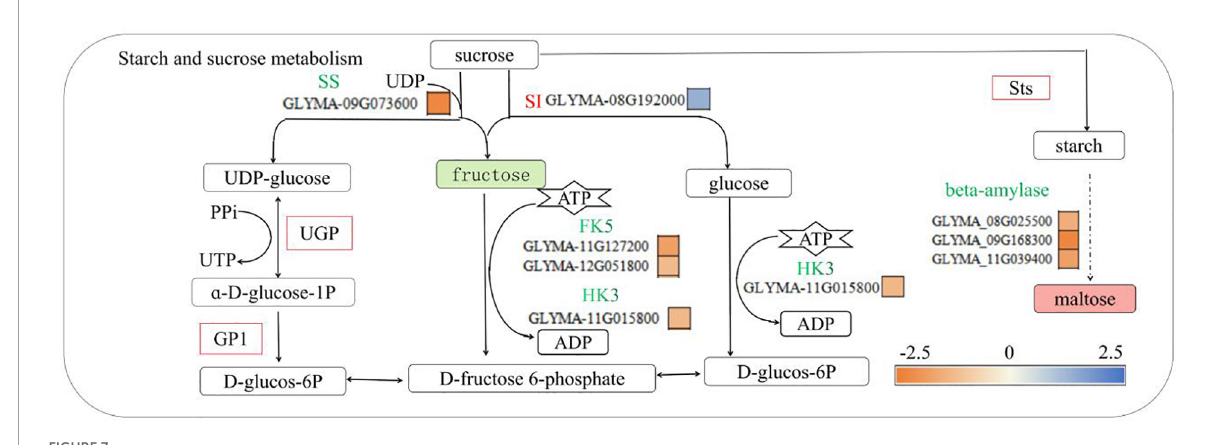
FIGURE7 Starch and sucrose metabolic pathways involved in phosphorus transport in soybean roots. SI, sucrose transferase; SS, sucrose synthase; HK3, hexokinase 3, FK5, fructokinase 5, UGP-UDPG pyrophosphatase, Sts, starch synthase, UGP-UDPG pyrophosphorylase; bata- amylase, beta-amylase. Green solid squares indicate downregulated metabolites, red solid squares indicate upregulated metabolites, red fonts indicate upregulated genes, green fonts indicate downregulated genes, red squares indicate upregulated proteins, and yellow and blue squares indicate fold changes in gene expression.